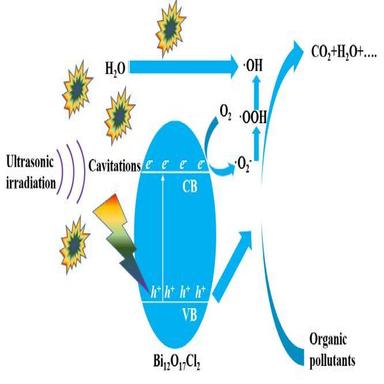
The schematic diagram of proposed sonocatalytic mechanism of Bi12O17Cl2 series.